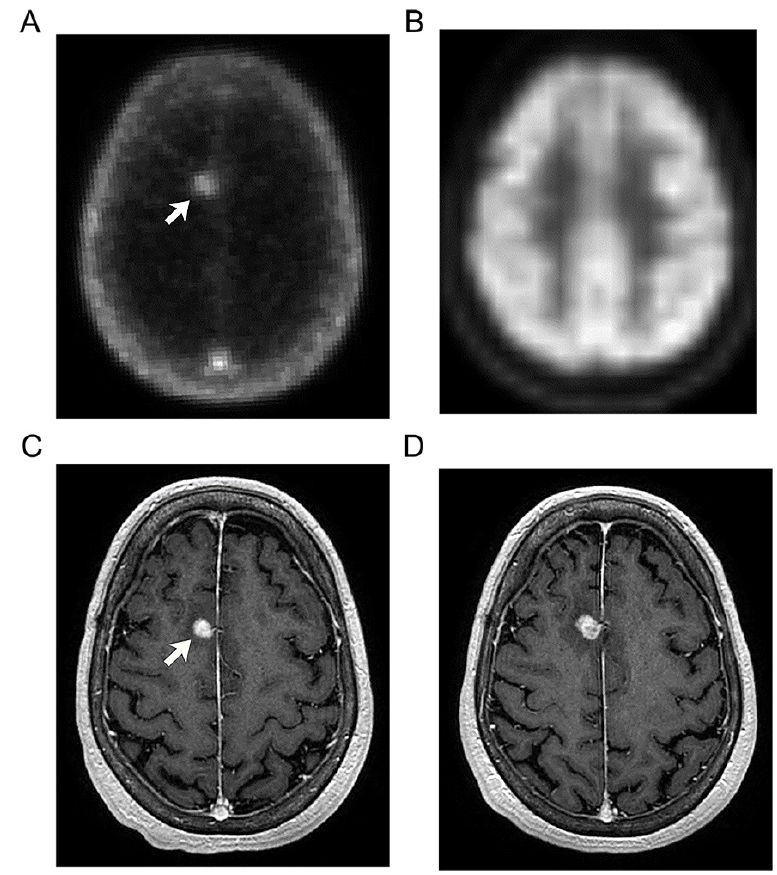
Figure 2. Recurrent brain metastasis in 60-year-old woman with malignant melanoma. [ 124 I]I-NM404 ( A ) and [ 18 F]FDG ( B ) PET images 8 months after stereotactic radiosurgery for tumor recurrence of a right frontal falcine metastasis shows a focus of abnormal activity with NM404 (arrow) but no detectable abnormality with [ 18 F]FDG. Corresponding enhancing focus on MR imaging (( C ), arrow) was interpreted as radiation necrosis versus possible recurrence. Subsequent MR imaging ( D ) showed further increase in size of the nonspecific enhancing lesion, coupled with increased perilesional edema. Patient remains in close-interval imaging surveillance. Cervical lymphadenopathy in a 46-year-old man with metastatic squamous cell car- cinoma that originated from the tongue base (Figure 3).